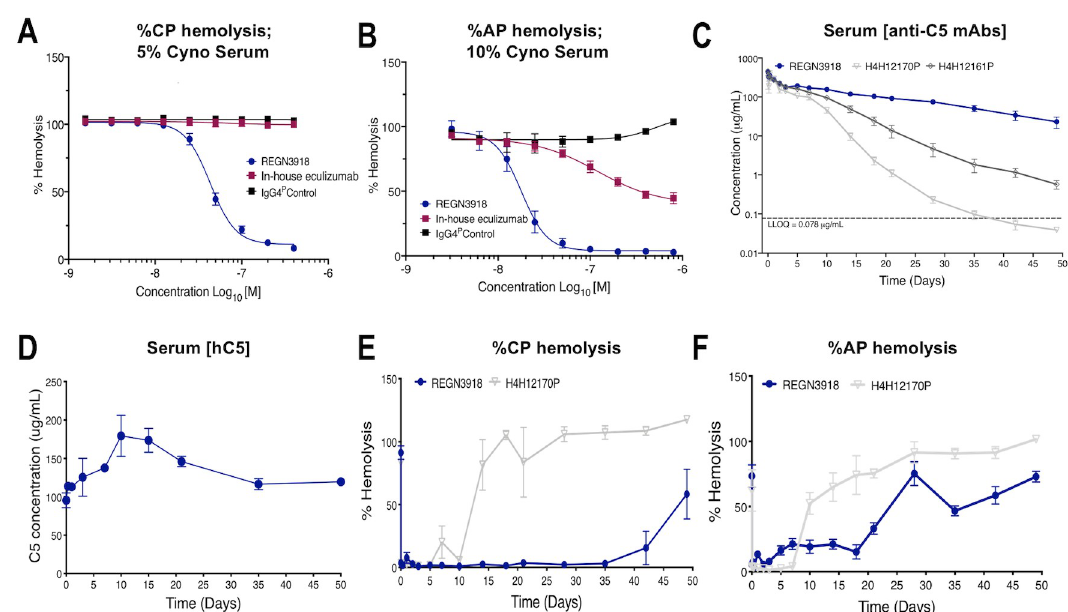
Fig 2. Characterization of the antihemolytic activity of anti-C5 antibodies in monkey serum. (A) SRBCs, sensitized with hemolysin in GVB ++ , were incubated for 60 minutes at 37˚C with 5% cynomolgus monkey serum, resulting in CP-mediated hemolysis. Pre-incubation of serum with increasing concentrations of REGN3918 blocked hemolysis in a dose-dependent manner. In-house eculizumab had no significant effect on hemolysis. (B) RbRBCs in GVB ++ -Mg 2+ /EGTA were incubated for 15 minutes with 10% cynomolgus monkey serum, resulting in AP-mediated hemolysis. Pre-incubation of serum with increasing concentrations of REGN3918, but not in-house eculizumab, fully blocked hemolysis in a dose-dependent manner. For hemolysis assays (A, B), representative experiments are shown that was performed in duplicate at each mAb concentration; each experiment was repeated with multiple sera from different donors (n > 3). (C) The serum concentrations of REGN3918 (blue), H4H12161P, and H4H12170P antibodies were measured in cynomolgus monkeys at 5 minutes, 4 and 8 hours, and 1, 2, 3, 5, 7, 10, 14, 18, 21, 28, 35, 42, and 49 days after administration of a single 15 mg/kg intravenous dose of each antibody (n = 4 for C-F). (D) hC5 serum concentrations were measured at predose, 8 hours and 1, 3, 7, 10, 15, 21, 35 and 50 days post dose in cynomolgus monkeys administered a single 15 mg/kg intravenous dose of anti-REGN3918. (E-F) Serum from monkeys dosed with REGN3918 (blue) or H4H12170P were collected at 5 minutes, 4 and 8 hours, and 1, 2, 3, 5, 7, 10, 14, 18, 21, 28, 35, 42, and 49 days and used to examine the percent of CP- (E) and AP- mediated (F) hemolysis. Data is plotted as mean ± SEM.